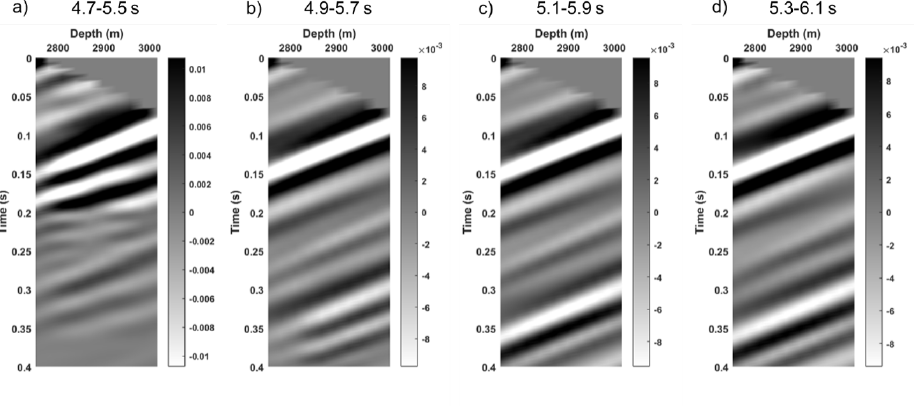
Figure 20. Reflection response from time-varying interferometry of check shot SP2. Times above each panel indicate the time window of the check shot record used as an input for